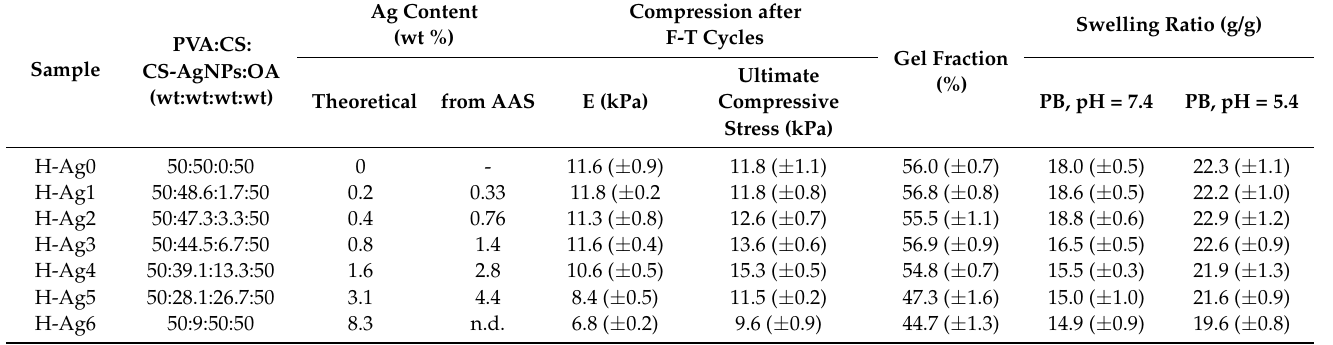
Table 3. Composition and physicochemical properties of the composite hydrogels containing CS- AgNPs.